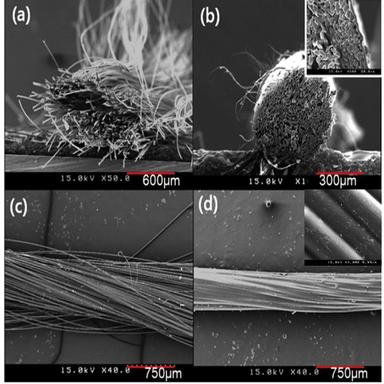
Scanning electron micrograph: (a) cross-section of untreated p-aramid fiber, (b) cross-section of treated p-aramid fiber with PI, (c) surface of untreated paramid fiber, (d) surface of treated p-aramid fiber with PI.